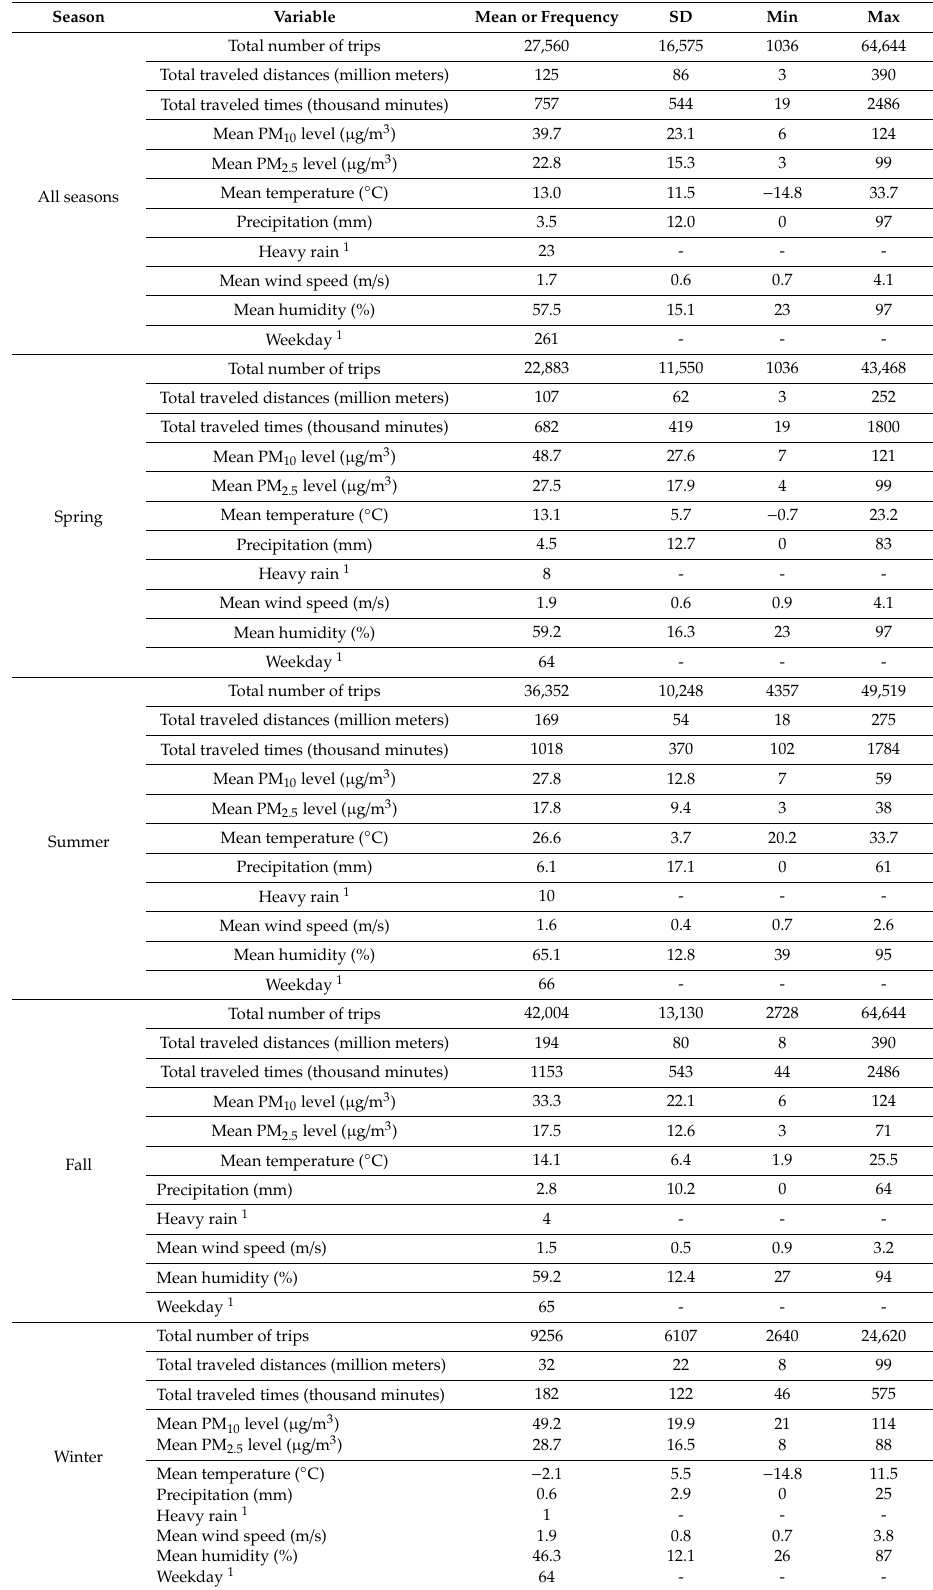
Table 2. Descriptive statistics of variables by